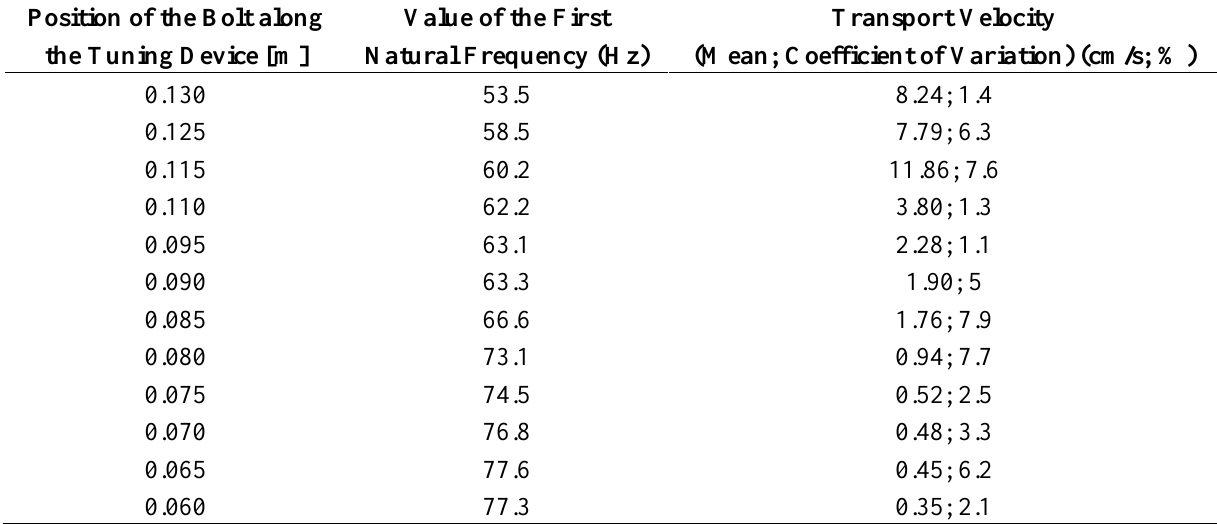
Table 2. Values of the first natural frequency of the conveyor and mean transport velocity for different positions of the tuning